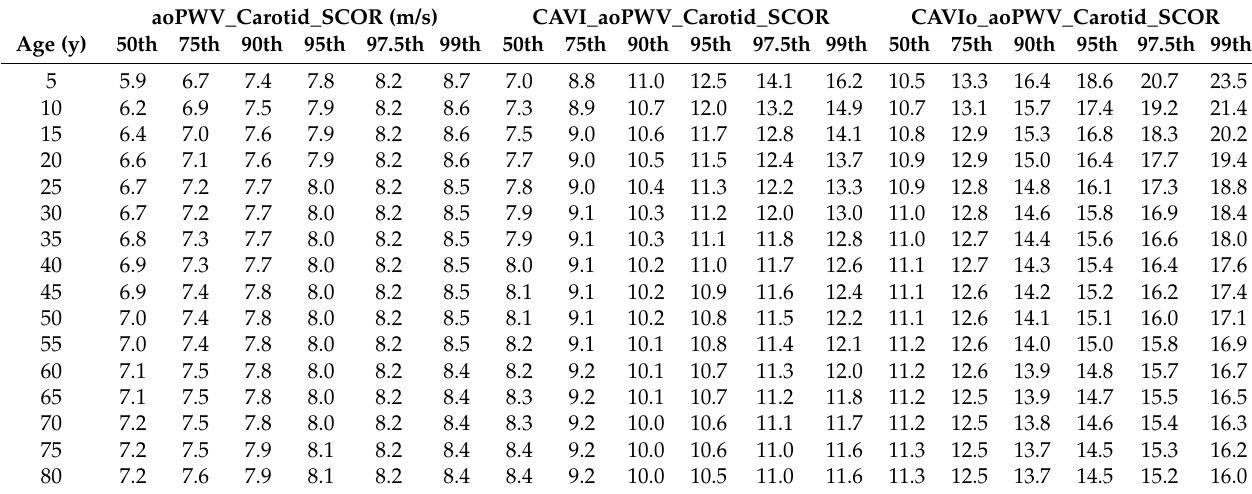
Table 11. aoPWV_Carotid_SCOR levels and related parameters (CAVI and CAVIo) reference intervals: All.